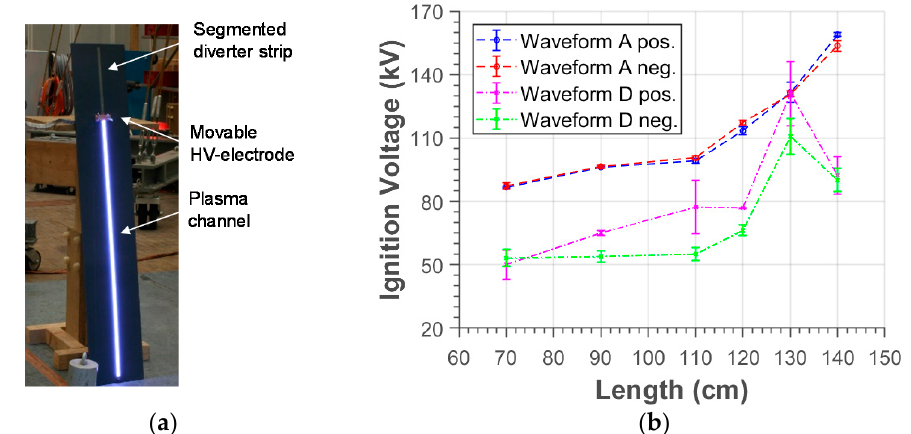
Figure 6. ( a ) A test setup with an ignited segmented diverter strip, and ( b ) the average ignition voltage as a function of strip length.